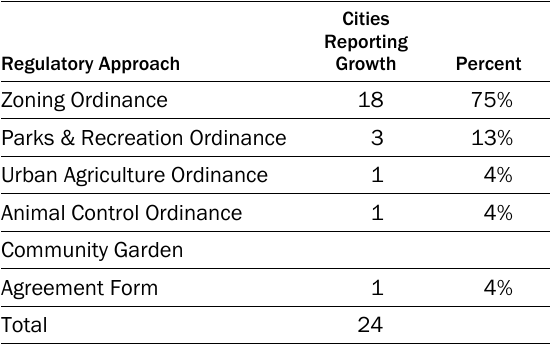
Table 5. Regulation of Urban Agriculture: